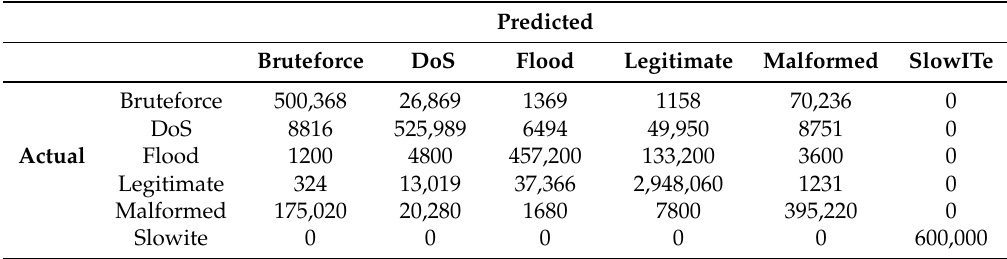
Table 13. Confusion matrix neural network with augmented and balanced traffic.